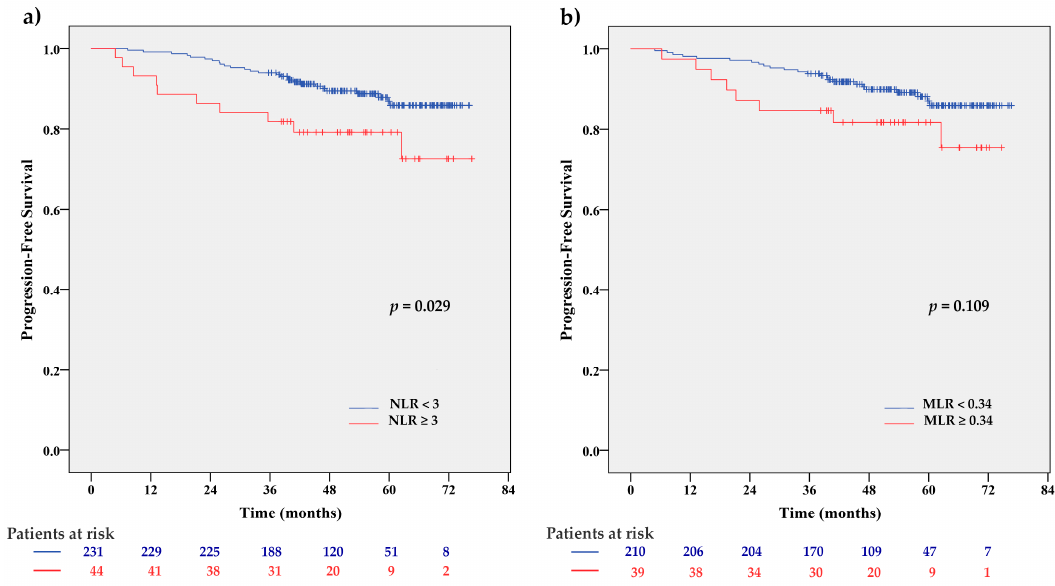
Figure 2. Kaplan–Meier PFS estimates for NLR ( a ) and MLR ( b ) status. PFS was significantly reduced in patients with NLR ≥ 3 compared to those with NLR < 3 ( p = 0.029 by Log-rank test), while the difference was not significant for MLR ( p = 0.109 by Log-rank test).